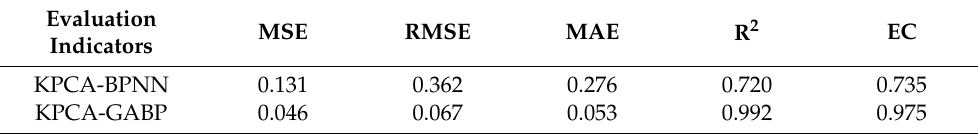
Table 4. Performance evaluation of the investigated ML